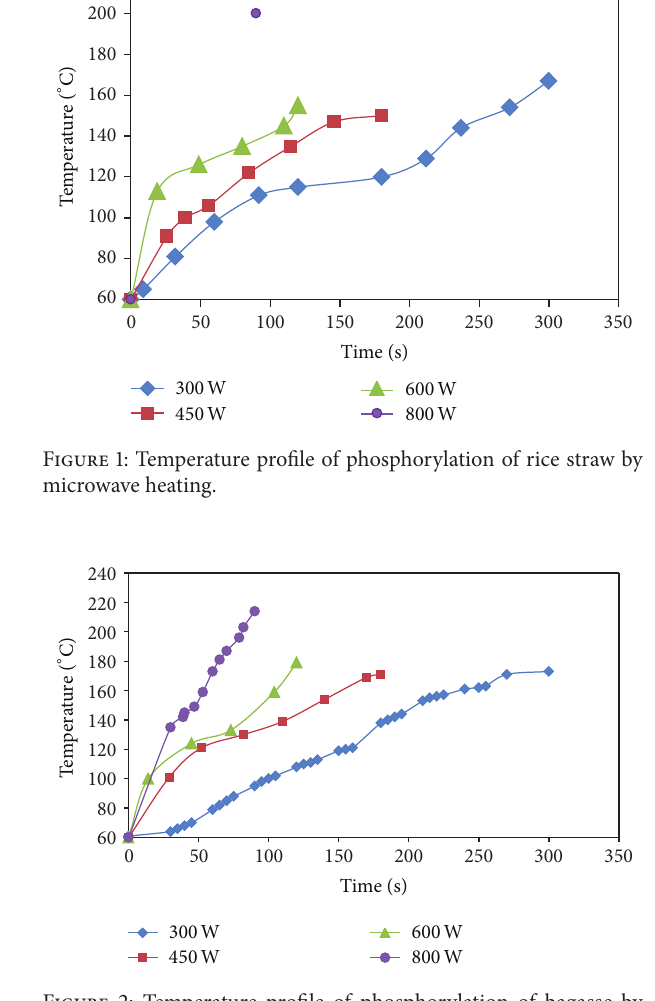
Figure 2: Temperature profile of phosphorylation of bagasse by microwave